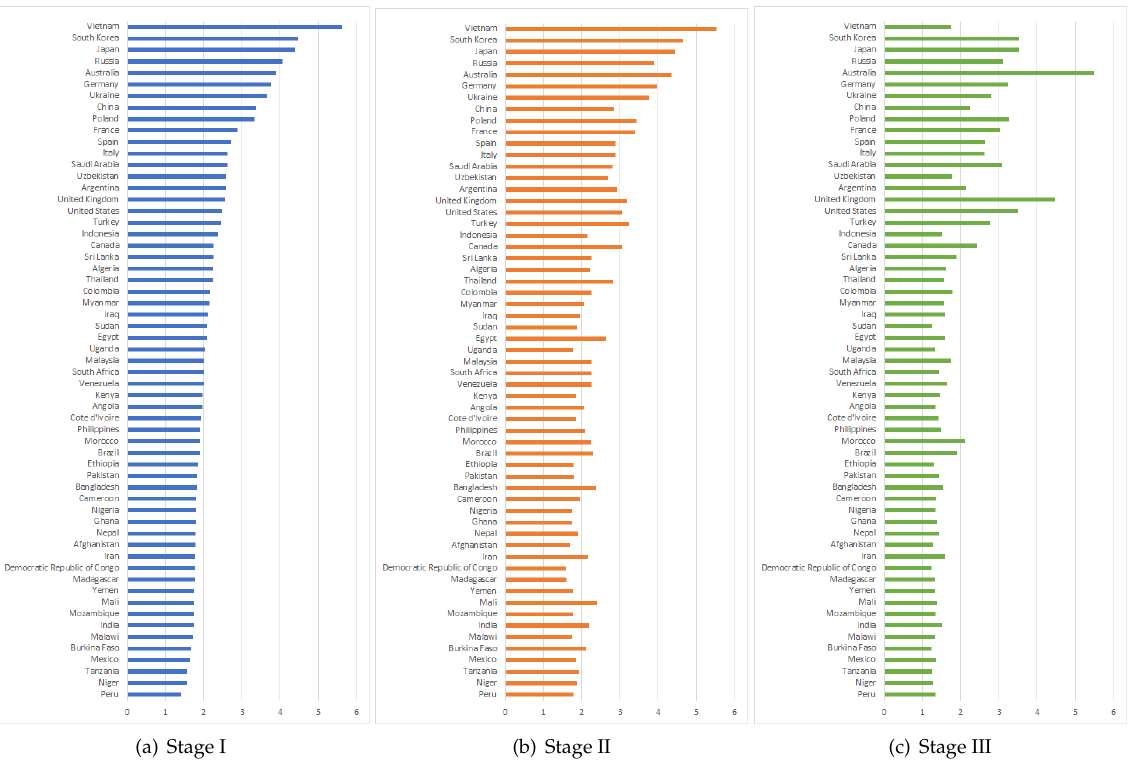
Figure A1. Performance scores of part of countries.